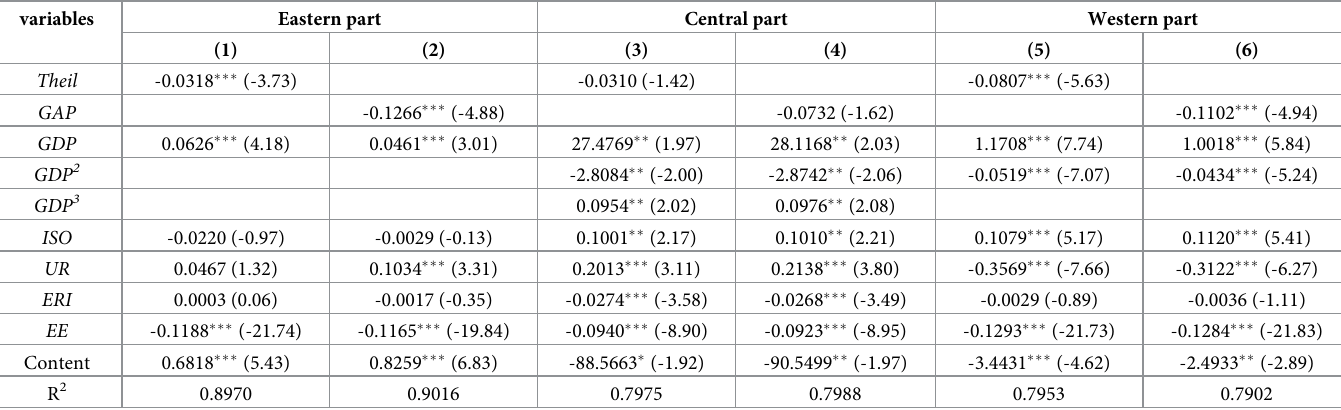
Table 7. Results of the urban-rural income gap on pollution control by